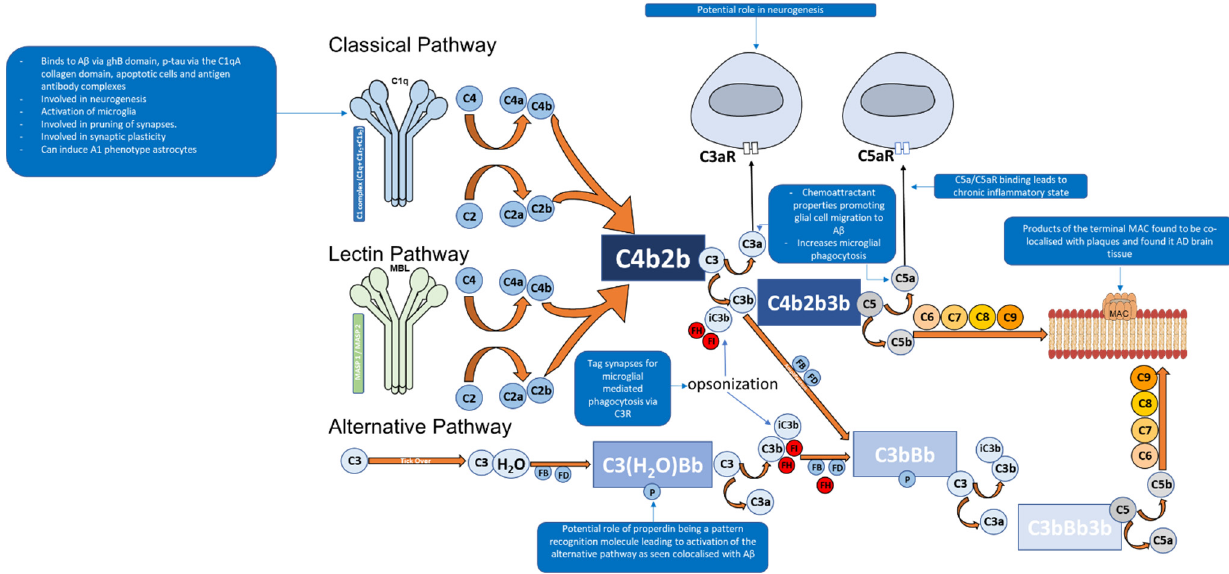
Figure 2. The complement system consists of more than 40 soluble or membrane-bound proteins, and is activated via classical, lectin or alternative pathway. The classical pathway is activated by A β andp-tau. Apoptotic cells and antigen- antibody complexes interact with C1q (complexed with C1r 2 and C1s 2 ). C1s then cleaves C4 and C2 and ultimately leading to the formation of C3 convertase C4b2b. The lectin pathway is activated by mannan-binding lectin (MBL) and ficolin, which then recruits MASPs (MBL-associated serine proteases) to cleave C2 and C4, yielding C3 convertase, C4b2b. The alternative pathway is an amplification loop and is also initiated by hydrolysis of C3 to C3(H 2 O) which leads to the formation of C3 convertase, C3bBb. All three pathways lead to formation of C5 convertase (classical and lectin: C4b2b3b; alternative: C3bBb3b) generating C5b which binds to C6, C7, C8, and C9 to form a cell lysing membrane attack complex (MAC). Some of the mechanisms of complement activation in AD are shown in the blue boxes.